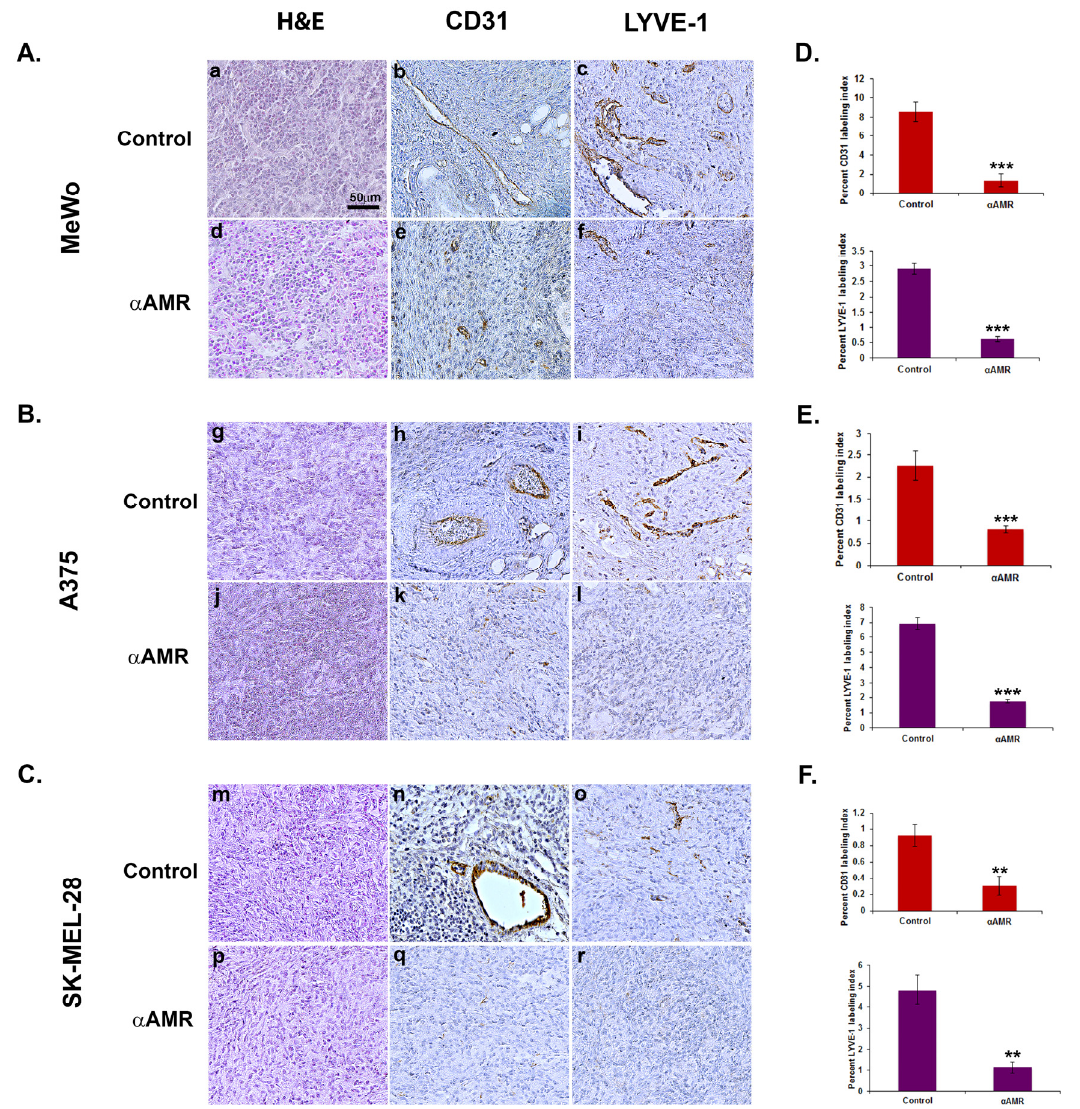
Figure 5. Analysis of in vivo Matrigel plug bioassays indicates that AM secreted by melanoma cells induces angiogenesis and lymphangiogenesis. ( A – C ) A total of 0.8 mL of growth factor-depleted Matrigel was admixed to MeWo (( A ), 1 × 10 6 cells) ( a , b , c , d , e , f ), A375 (( B ), 1.5 × 10 6 cells), or SK-MEL-28 (( C ), 2 × 10 6 cells) cells and administered to C57BL/6 mice via s.c. injection at the abdominal midline. Administration of α AMRs or control IgG was conducted intraperitoneally every three days (starting 24 h after initial Matrigel injection and for 15 days thereafter) in C57BL/6 mice. Formalin was used to fix Matrigel plugs, which were then embedded, sectioned, and used for immunohistochemical analysis. Figure 5A–C depict microphotographs of histochemical-stained Matrigel sections for H & E ( a , d , g , j , m , p ), blood vessel staining with the CD-31 antibody ( b , e , h , k , n , q ), and lymphatic vessels with the anti-LYVE-1 antibody ( c , f , i , l , o , r ) derived from Matrigel plugs mixed with melanoma cells treated with either α AMRs or control IgG. Each panel represents multiple fields, including five plugs in each group. Scale bar, 50 µ m. ( D – F ) Quantitative assessment of cell density for CD31- and LYVE-1-positive cells as assessed by staining conducted on the entire surface of the corresponding slides using CALOPIX software. (v2.10.16 by Tribvn) MBF_Image J 1.52a software was used for the analysis. The values represent the means ± SD (** p < 0.01; *** p < 0.001).